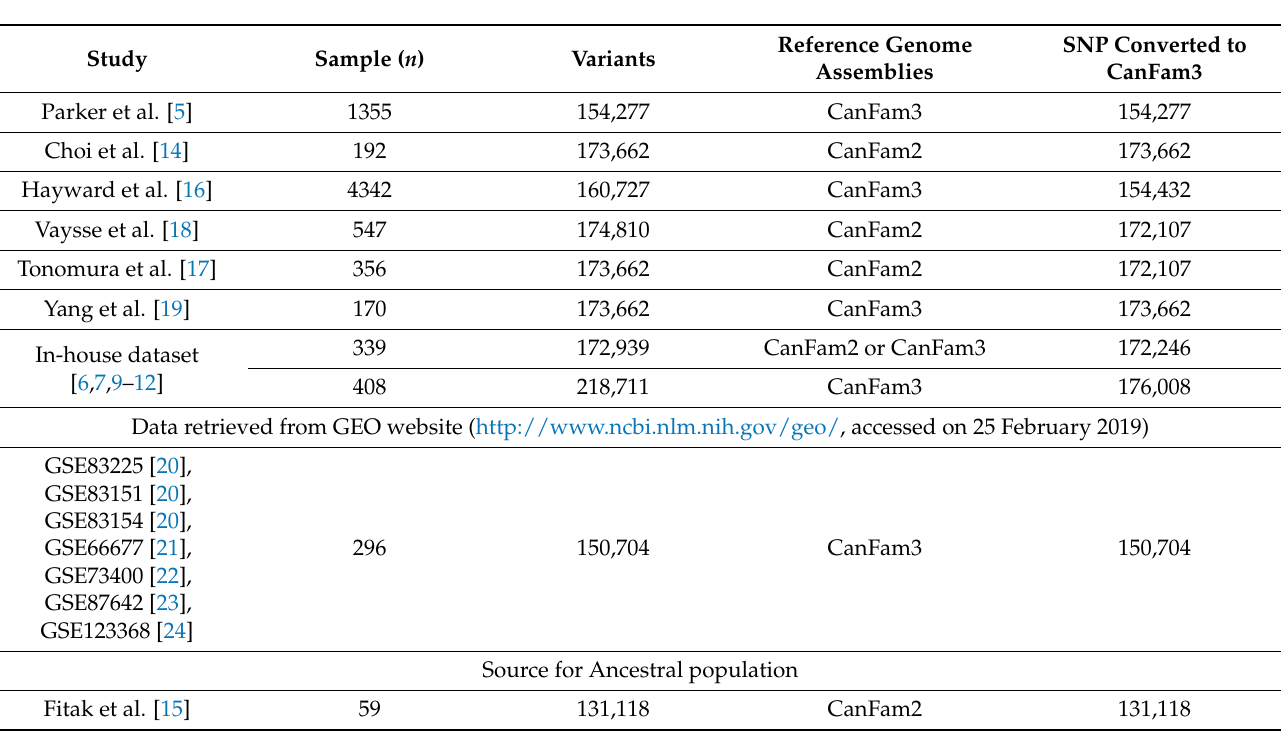
Table 1. The number of SNPs and dog samples in various datasets. A combined dataset of geno- types from 8006 dogs, representing 250 breeds, were obtained by merging public domain and in-house